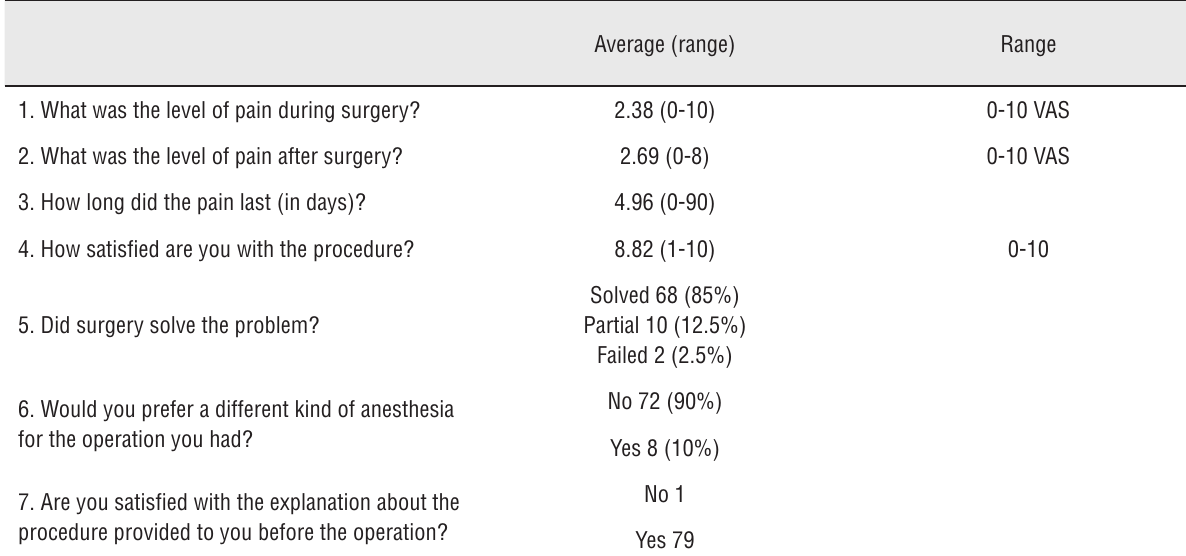
Table 2 - Results of the telephone